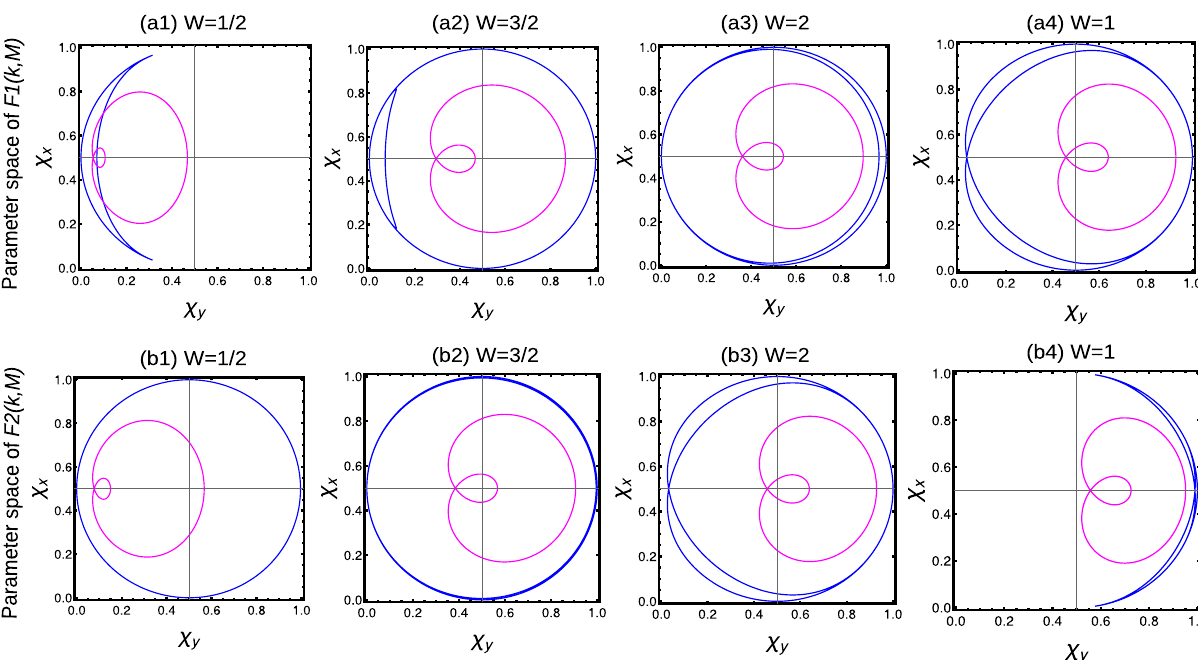
Figure 7. (Color online) Winding vector analysis of non-Hermitian extended-range SSH chain with two neighbors. The blue and magenta curves represent the zero temperature and T (28) and (29) respectively. ( a1 – a4 ) Behavior of extended winding vectors at parameter space corresponding to F 1 ( k , M ) . ( b1 – b4 ) Behavior of extended winding vectors at parameter space corresponding to F 2 ( k , M ) . The combined effect of F 1 ( k , M ) and F 2 ( k , M ) results in determining the topological property of the